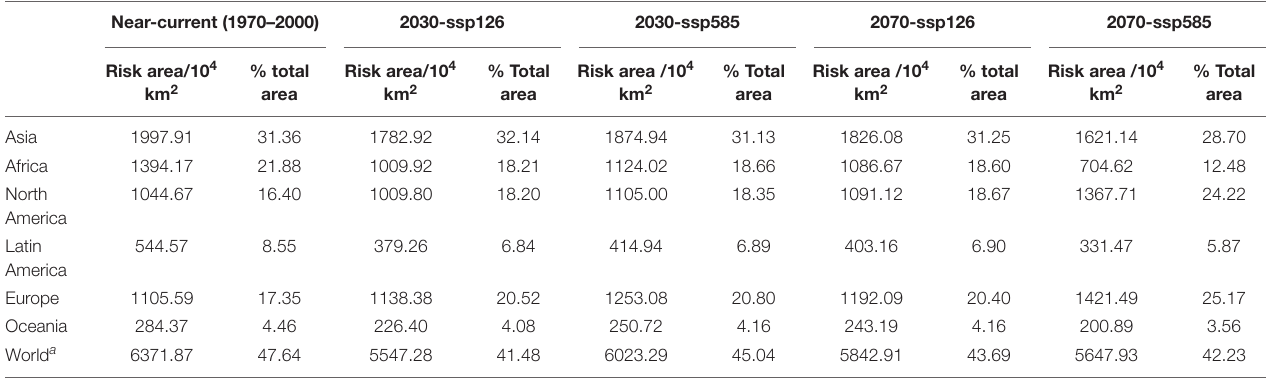
TABLE 2 | Projected risk area globally for Carpomya pardalina under near-current and future (2030 and 2070) climate scenarios expressed as an area (10 4 km 2 ) and as a percentage of the total area per continent, as predicted by MaxEnt modeling. Near-current